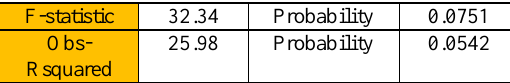
Table 5: Results of GARCH-LM Test F-statistic 32.34 Probability 0.0751 Obs- 25.98 Probability 0.0542 Rsquared